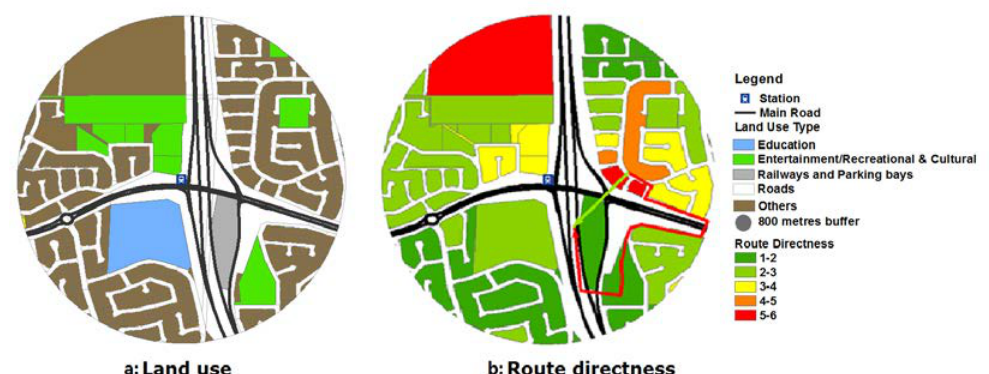
Figure 5. Land Use in the vicinity of Greenwood Station (a) and Route Directness for WnR